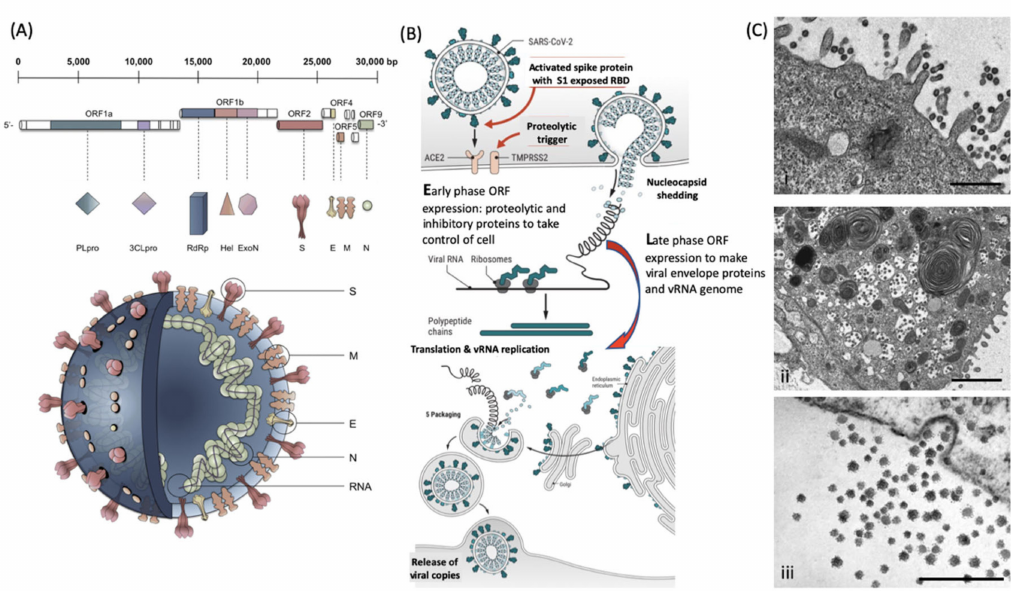
Figure 1. Molecular cellular pathology of SARS-CoV-2 infection: Panel ( A ) Schematic Illustration of SARS-CoV-2 viral RNA genome in relation to order of expression and functional incorporation with the Virion particle. The genome comprises a 5 (cid:48) -untranslated region (5 (cid:48) -UTR), open-reading frames (ORFs) 1a and 1b encoding nonstructural proteins 3-chymotrypsin-like protease (3CLpro), papain-like protease (PLpro), helicase (Hel), and RNA-dependent RNA polymerase (RdRp) as well as accessory proteins, and the structural S protein (S), E protein (E), M protein (M), and Nucleocapsid protein (N) in ORFs 2,4,5 and 9. Panel ( B ). Schematic of virion fusion mediated by Spike protein attachment to the ACE2 receptor and accessory cleavage of the Spike protein quaternary complex, resulting in fusion peptide exposure and binding to target cell plasma membrane. Focal, host cell and viral envelope lipid bilayer membrane fusion and viral RNA ingress of the target host cell. Shedding of Nucleocapsid and early ORF expression to take control of the cell and inactivate internal anti-viral proteins (e.g., Ubiquitin and RNase). Late ORF expression: replication of viral RNA genome and expression of, via post-translational processing mechanisms of the endoplasmic reticulum and Golgi apparatus (e.g., glycosylation),